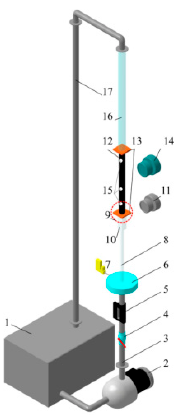
Figure 1. The scheme of the experimental facility. 1—main tank; 2—pump; 3—supply line; 4—control